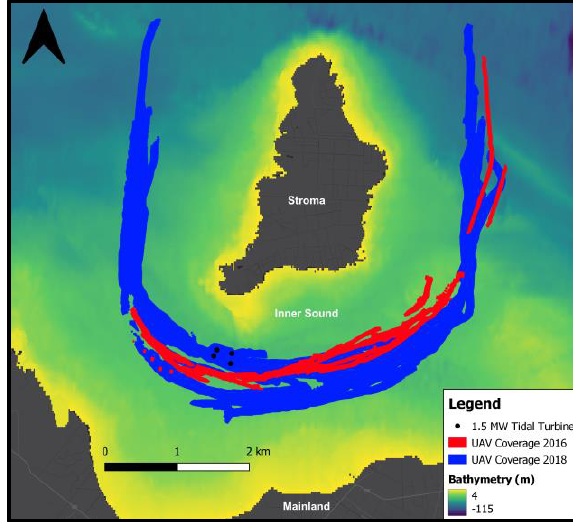
Fig. 2. UAV area coverage of all surveys carried out in